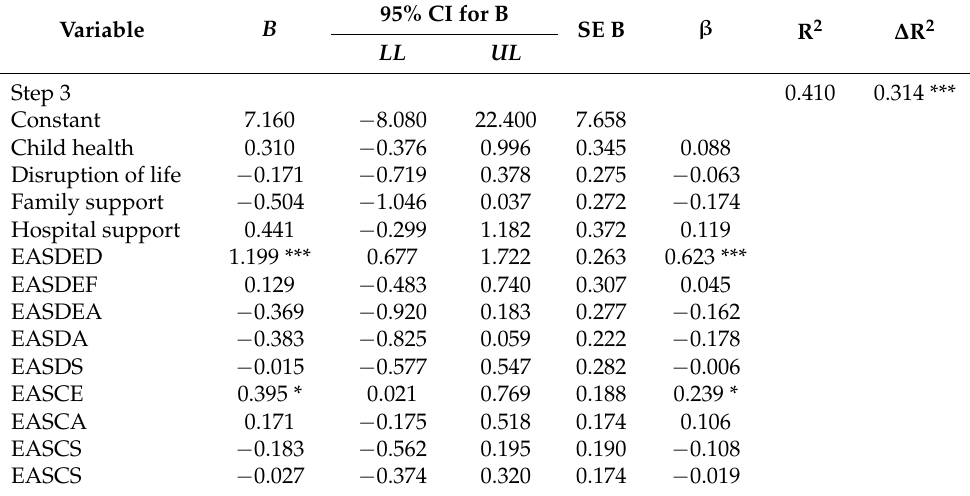
Table 6. Stress predictors in the group of parents of younger